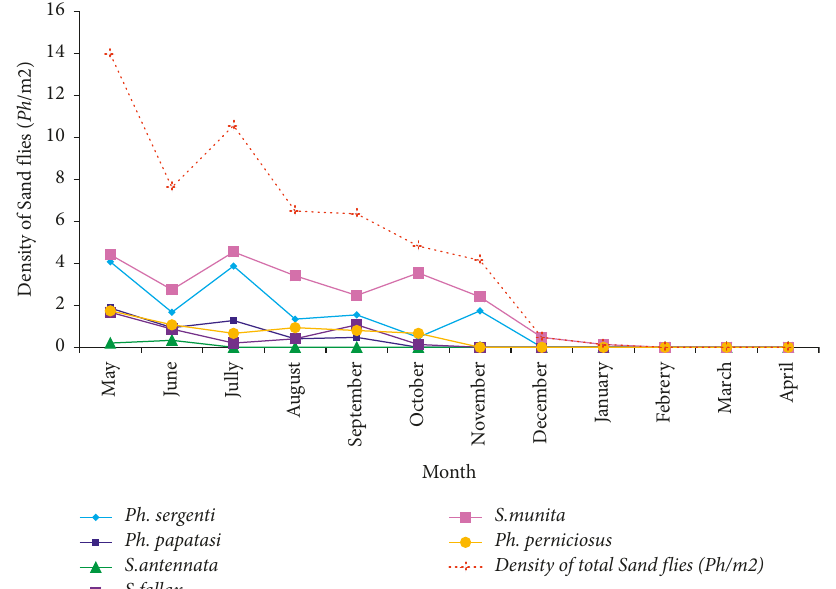
Figure 2: Seasonal dynamics of different specimens of sand flies captured from different stations in Fez city from May 2017 to April 2018.